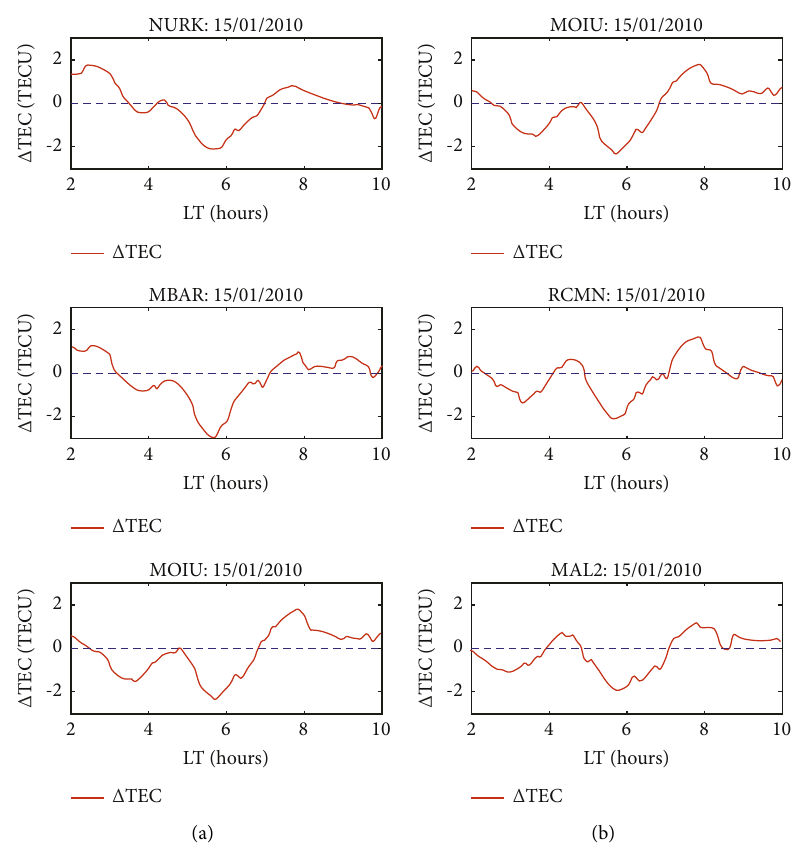
Figure 5: The detrended TEC (red line) and mean level (blue line) variation with local time (LT) across (a) NURK-MBAR-MOIU and (b) MOIU-RCMN-MAL2 receivers array on 15 th January